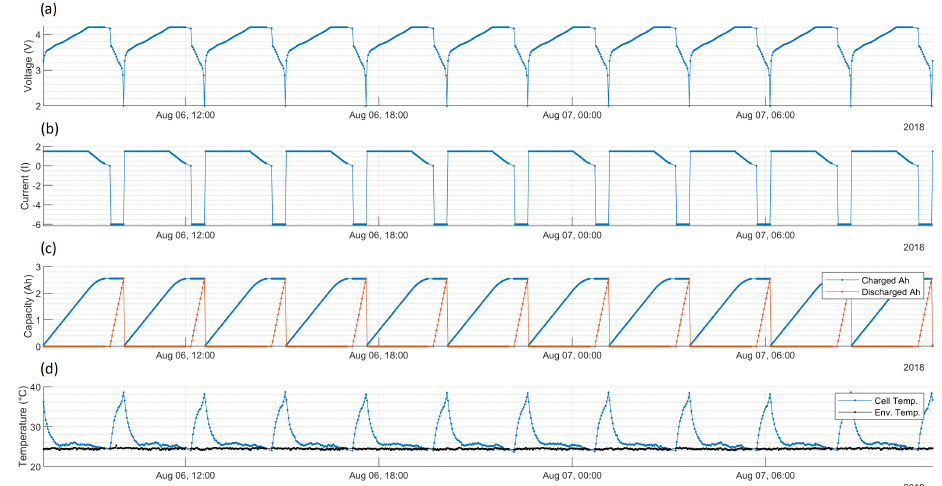
Figure 2. Example of constant current constant voltage charge profiles measured by Sandia National Laboratories during the performed experimental cell aging campaign. The cell operating parameters measured during the tests are ( a ) cell voltge (V), ( b ) current (A), ( c ) charged and discharged capacity (Ah), and ( d ) cell and environmental temperature